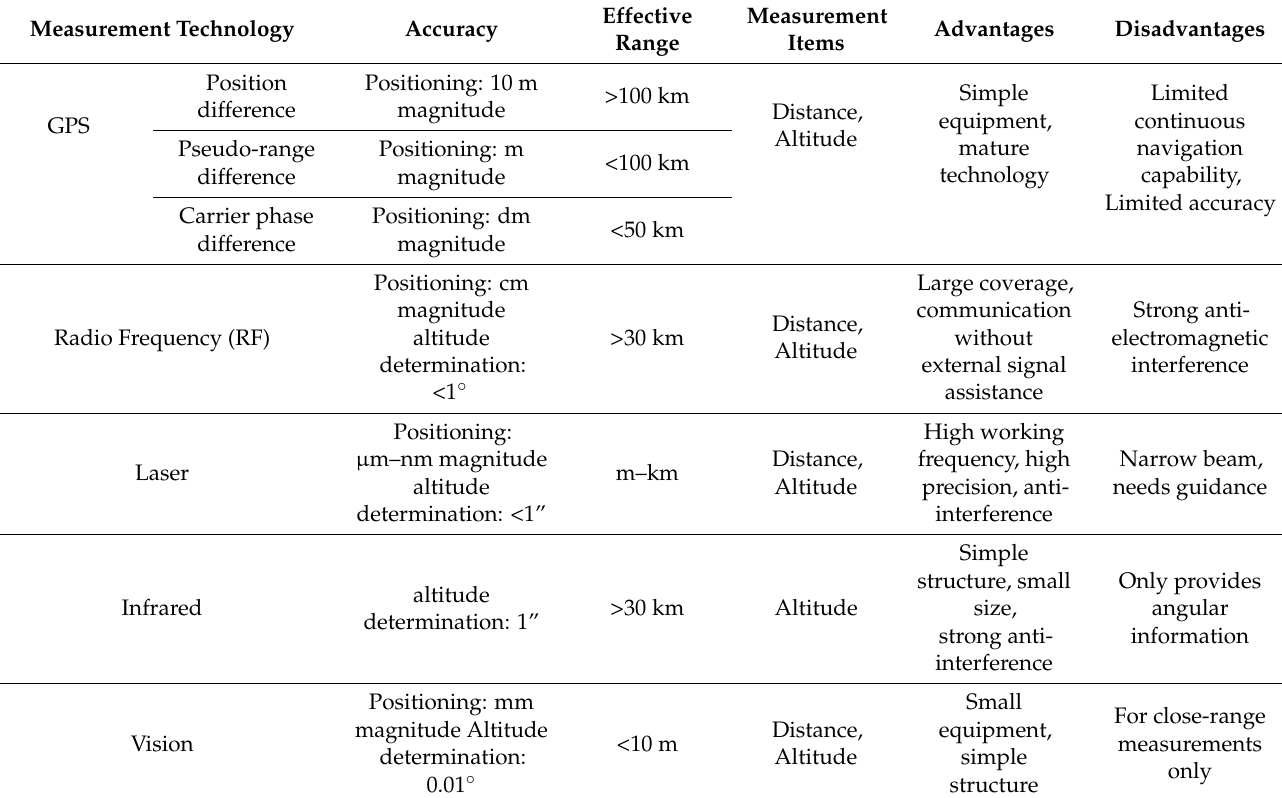
Table 10. Relative state measurement technology